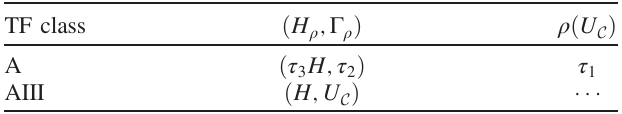
TABLE XVI. The mapped Hamiltonian (B6) and the repre- dimension-raising isomorphism ρ for the complex tenfold-way classes.